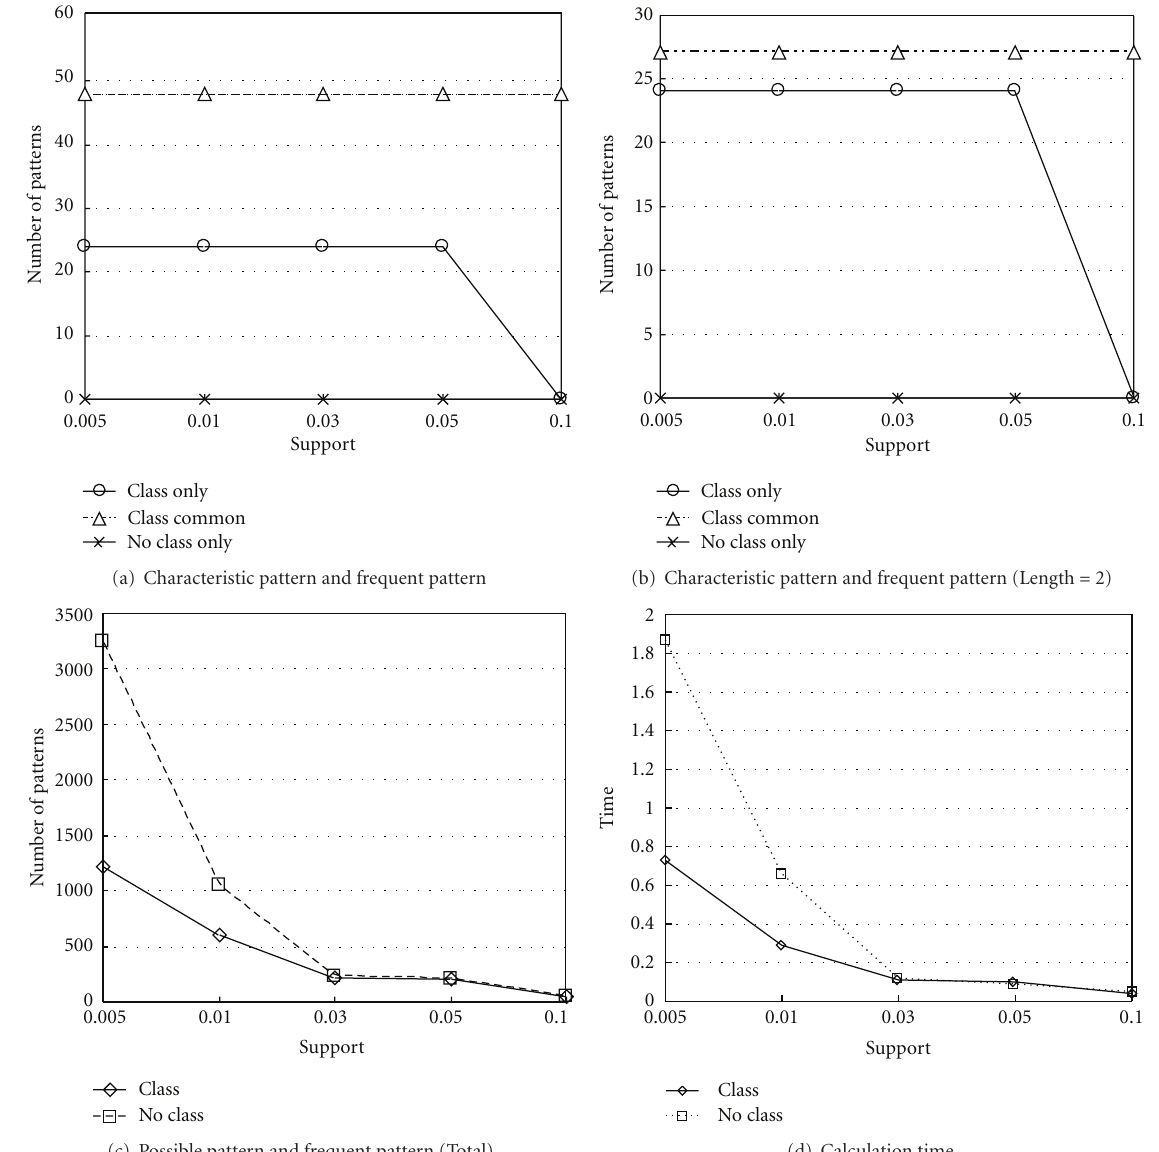
(b) Characteristic pattern and frequent pattern (Length = 2)